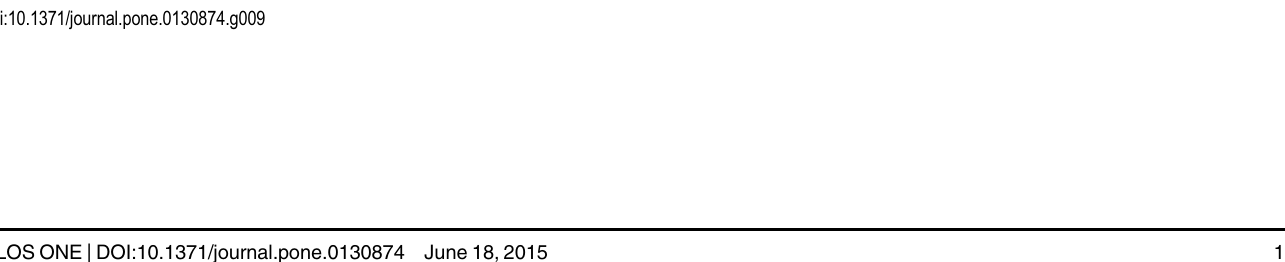
PLOS ONE | DOI:10.1371/journal.pone.0130874 June 18,